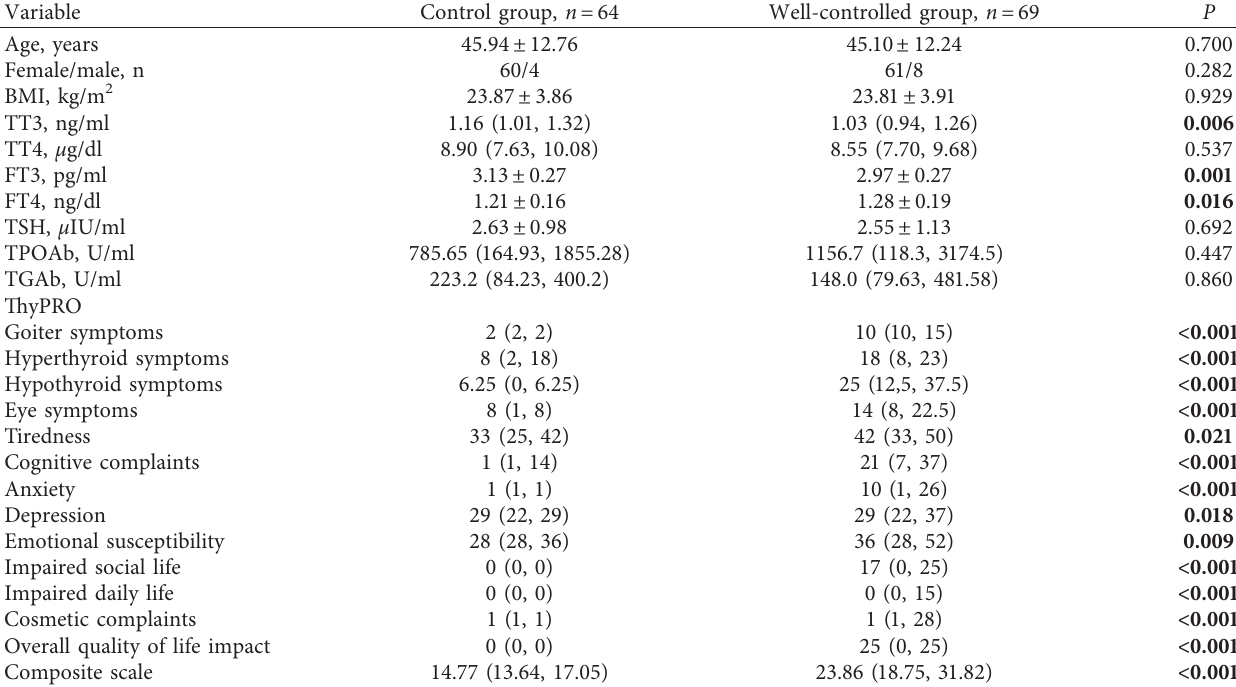
Table 1: Comparison of clinical characteristics and ThyPRO scores between the two groups.